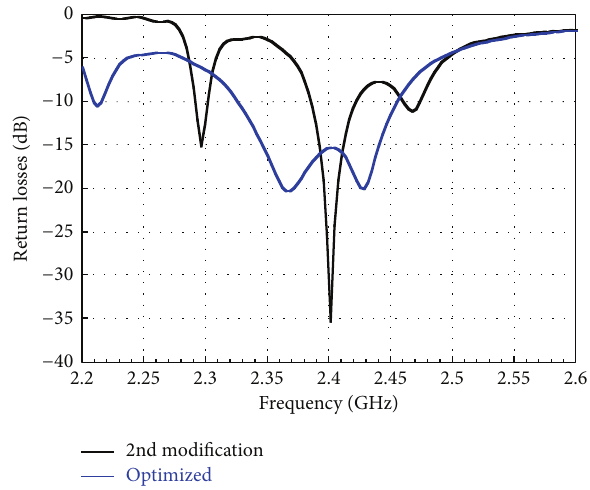
Figure 14: Comparison between sharp and softened ends antennas.